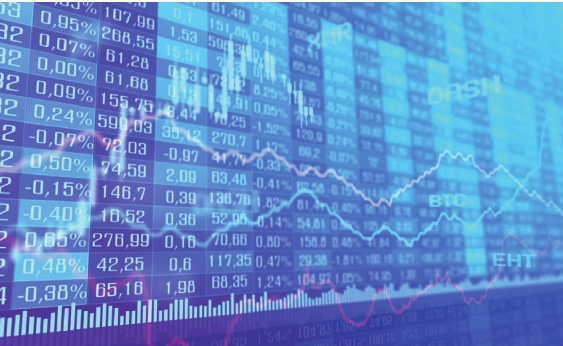
Figure 1: Capital market (source: